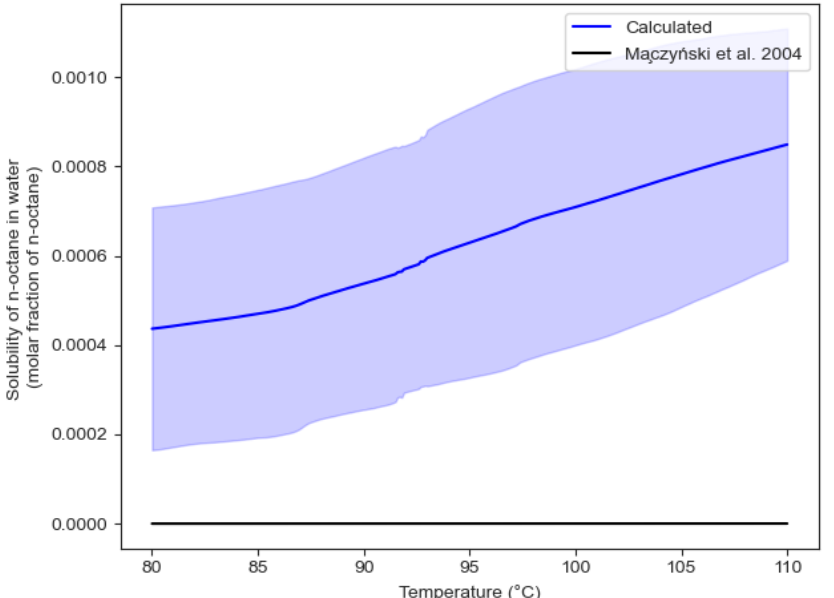
Figure 19. Solubility of n-octane in water in the temperature range of interest. Note: blue bands represent the 95% confidence interval. Table 7. Constants for K-value correlation of water/n-octane